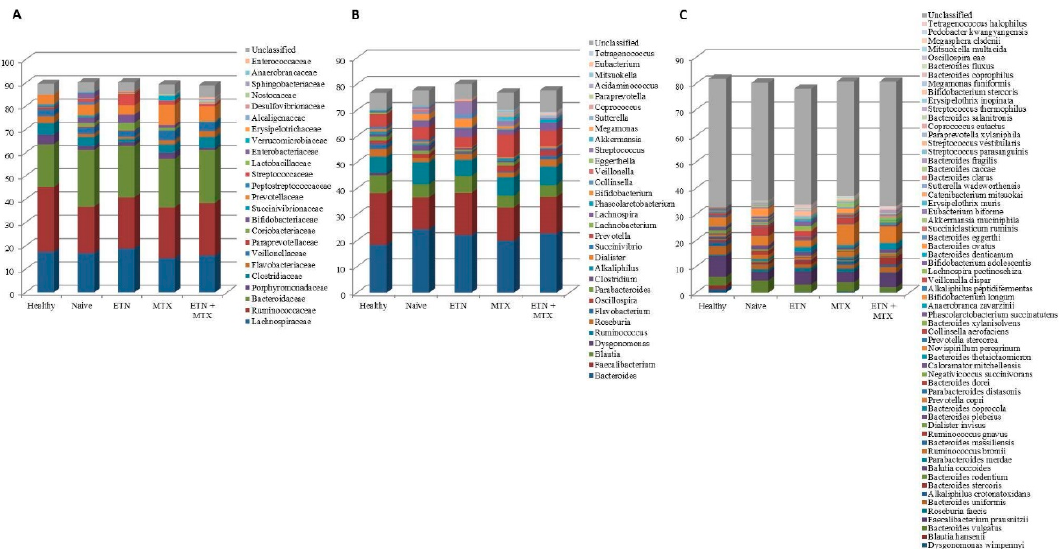
Figure 3. Microbiota composition of healthy controls and different treatment groups of RA patients at the family ( A ), genus ( B ), and species ( C ) levels. The mean value of the eight top taxonomic classifications at each level is represented.